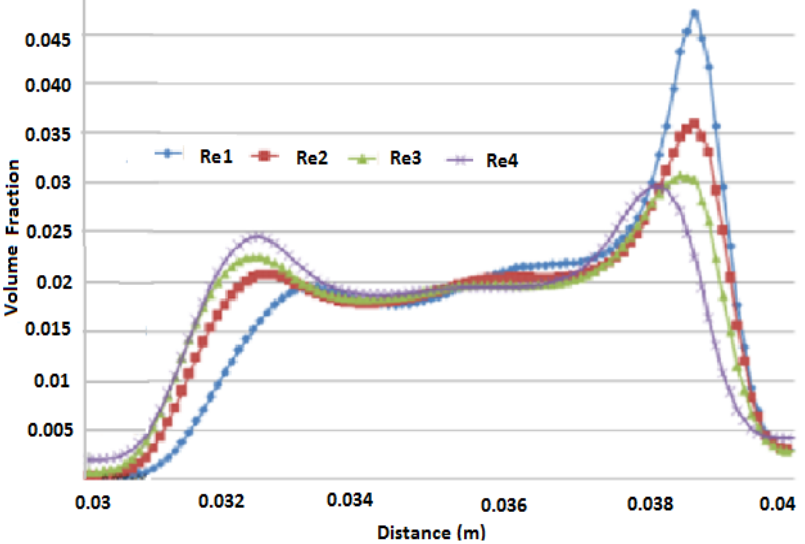
Figure 6. Variation of solid phase volume fraction (for W 9 slurry) for different slurry velocities at constant RPM of inner wall along plane 4